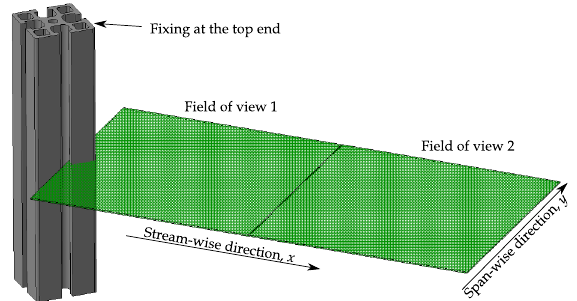
Fig. 1. Sketch of the positions of both fields of view relative to the obstacle. Obstacle dimensions: 45 × 45 × 200mm, field of view dimensions: 164 × 164mm, distance of FoVs from the axis of the obstacle: 17mm and